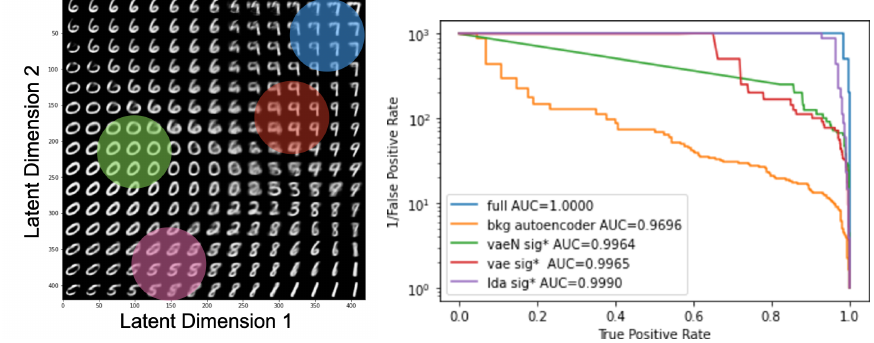
Figure 3 . (Left) Illustrative plot of a 2-Dimensional latent space generated from a VAE trained on all of the digits 0-9. Colors indicate rough regions of interest for the digit 0 (green), 9 (red), 5 (purple), and 7 (blue). (Right) Exploration of different QUAK approaches as presented using the ROC applied on the separating of the digit 5 vs. the digit 9. We show the performance for (orange) a single autoencoder loss trained on the digit 5, (blue) a fully supervised network training the digit 5 vs. the digit 9, (red) a dense network trained to separate the digit 5 from 7 on a 2D QUAK space consisting of the loss of the digit 5 on one axis, and the loss of the digit 7 on another axis, (green) a dense network trained to separate the digit 5 from 7 on a 9D QUAK space consisting of the loss of each digit 0–8, (purple) a linear discriminant trained to separate the digit 5 from 7 on the same 9D QUAK space consisting of the loss of each digit